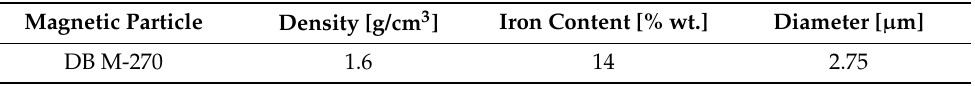
Table 2. Physical properties of Dynabeads™ M-270 (ThermoFisher)